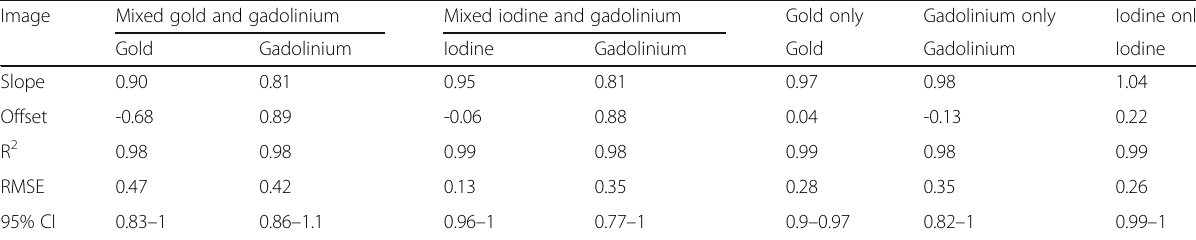
RMSE root mean square error, CI confidence